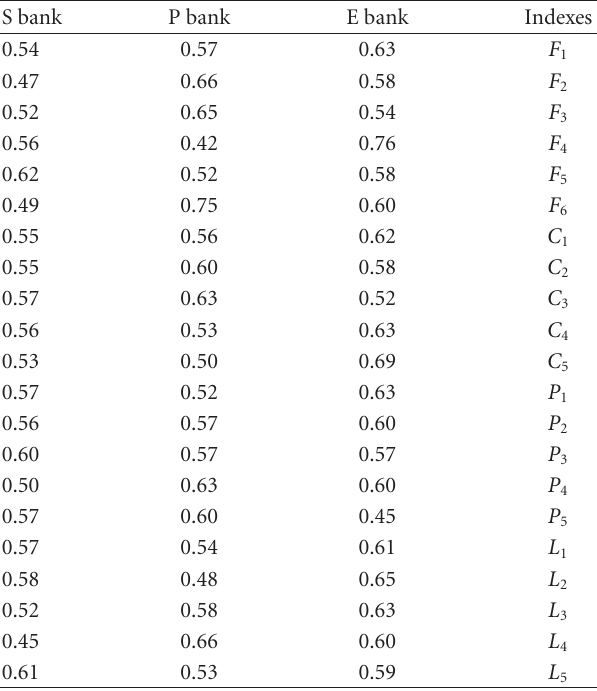
Table 4: Indexes weight of three banks by FAHP.